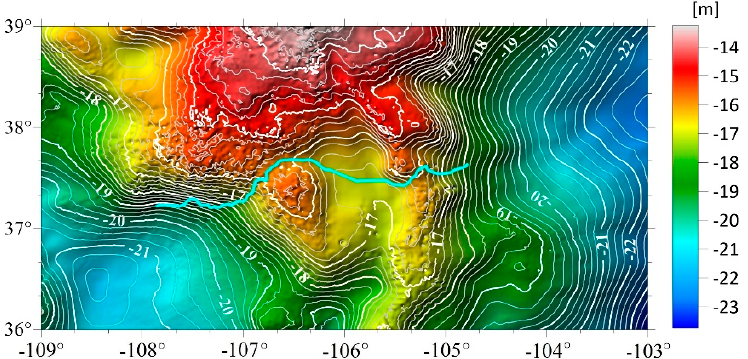
Figure 7. Map of geoid to quasigeoid separations used to determine the geoid model. The map of the determined geoid model is presented in Figure 8.